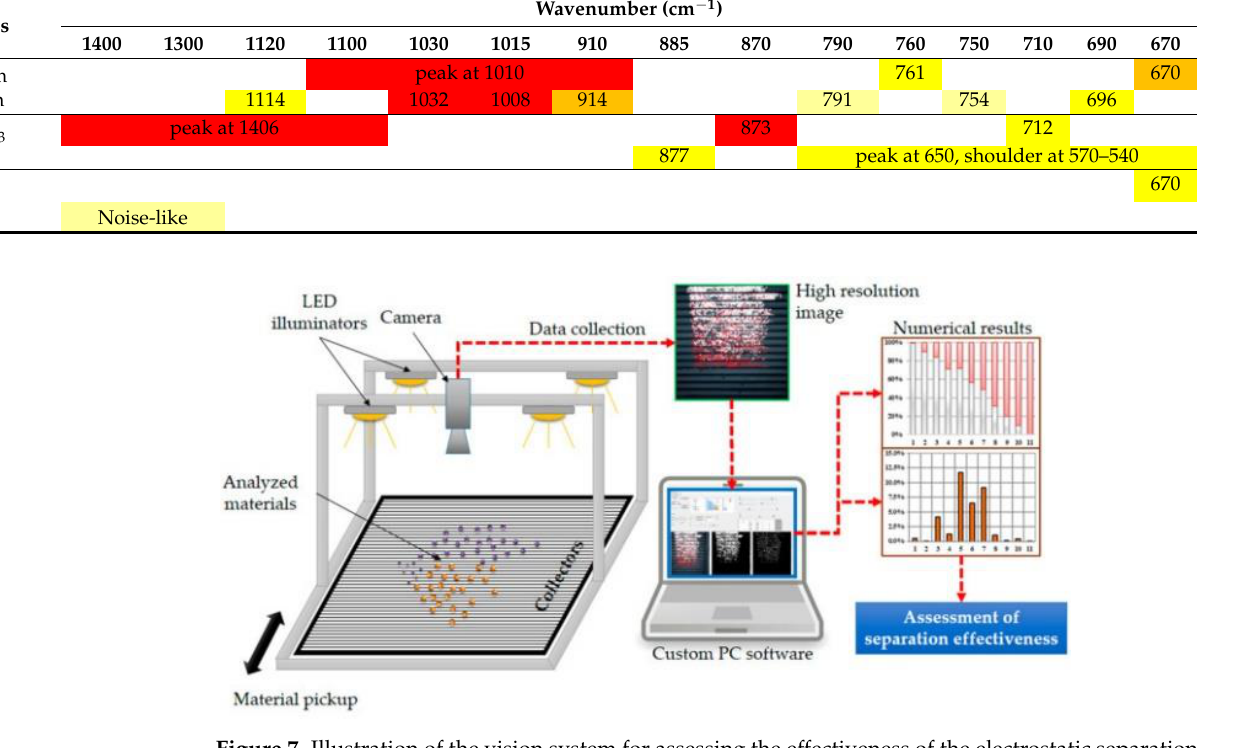
Figure 7. Illustration of the vision system for assessing the effectiveness of the electrostatic separation process. Reprinted with permission from ref. [20].